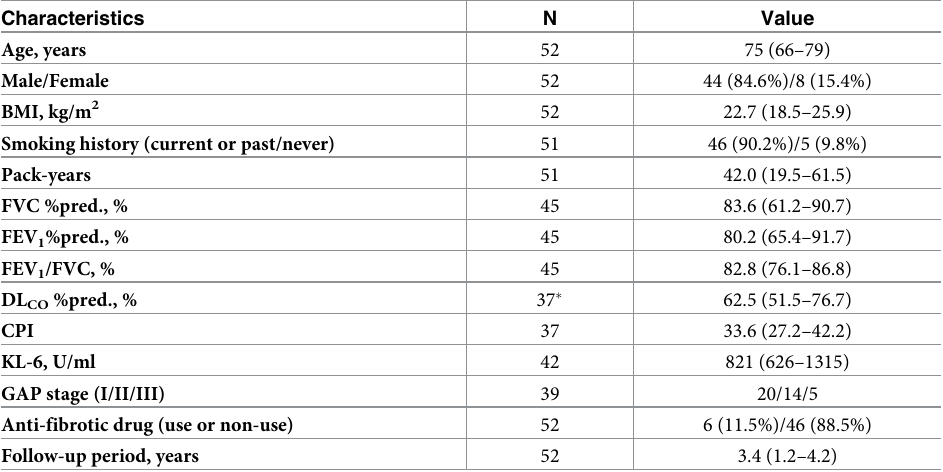
Table 1. Demographic, clinical, and physiologic characteristics of patients with idiopathic pulmonary fibrosis.